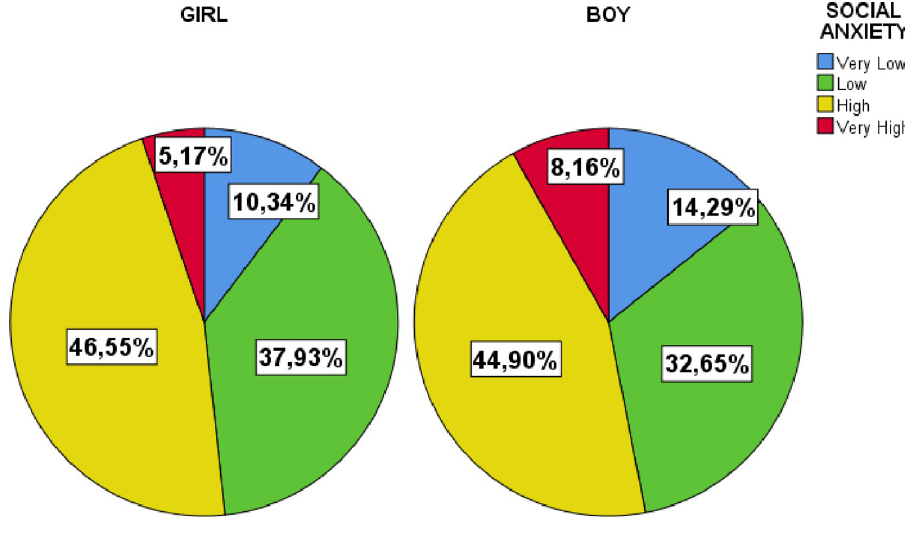
Fig 1. Social anxiety in boys and girls.